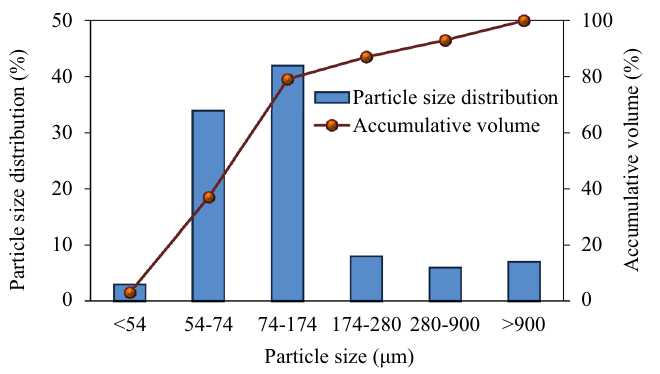
Figure 1. Particle size distribution of fly